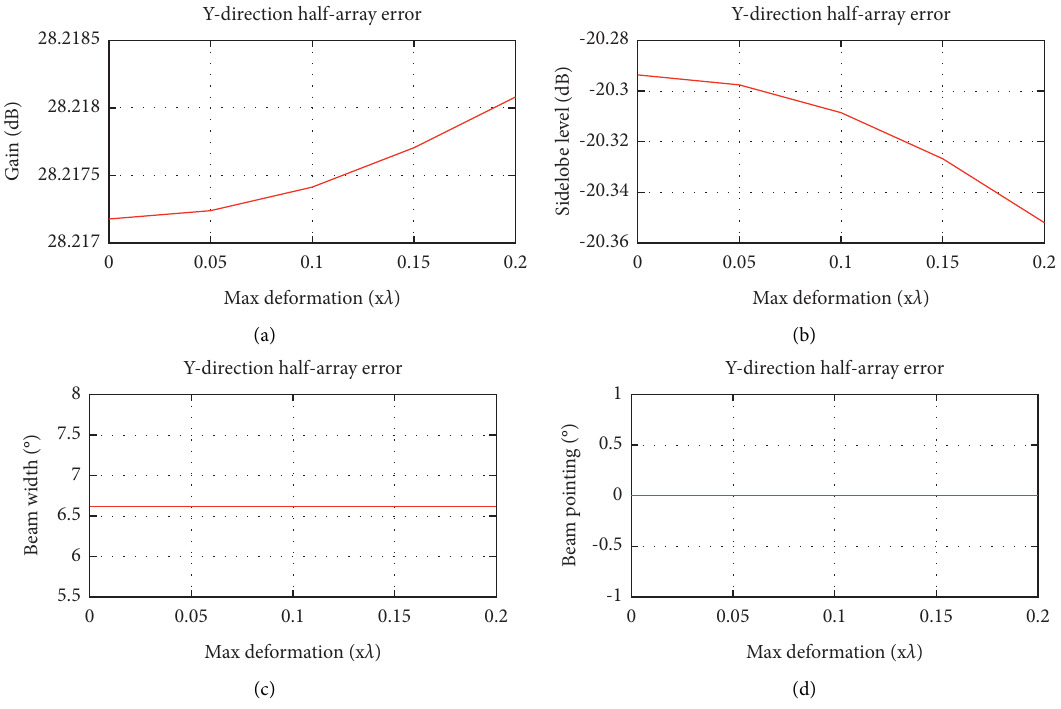
Figure 14: Changes in technical indicators caused by the position error of the left and right half arrays in the Y -direction. (a) Gain. (b) Sidelobe level. (c) Beam width. (d) Beam